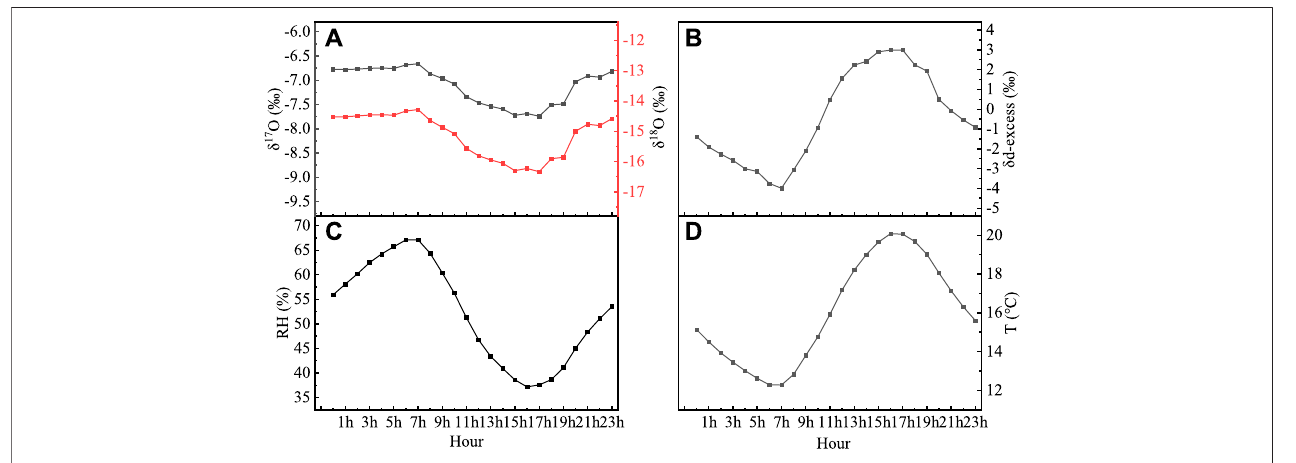
FIGURE 7 | Daily cycle of the atmospheric water vapor monthly average δ 18 O, δ 17 O (A) , d-excess (B) , relative humidity (C) , and temperature (D) .